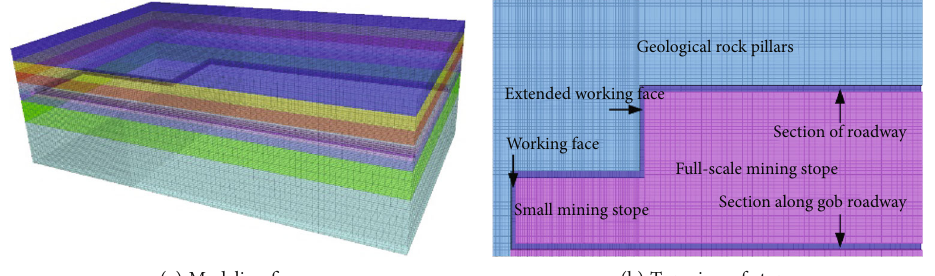
Figure 23: FLAC 3D modeling